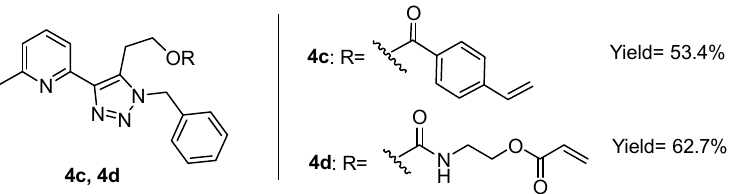
Figure 2. Structure of the ligands bearing a polymerisable unit. Ligand 4c has a styrenic functionality, while 4d has an acrylate unit.